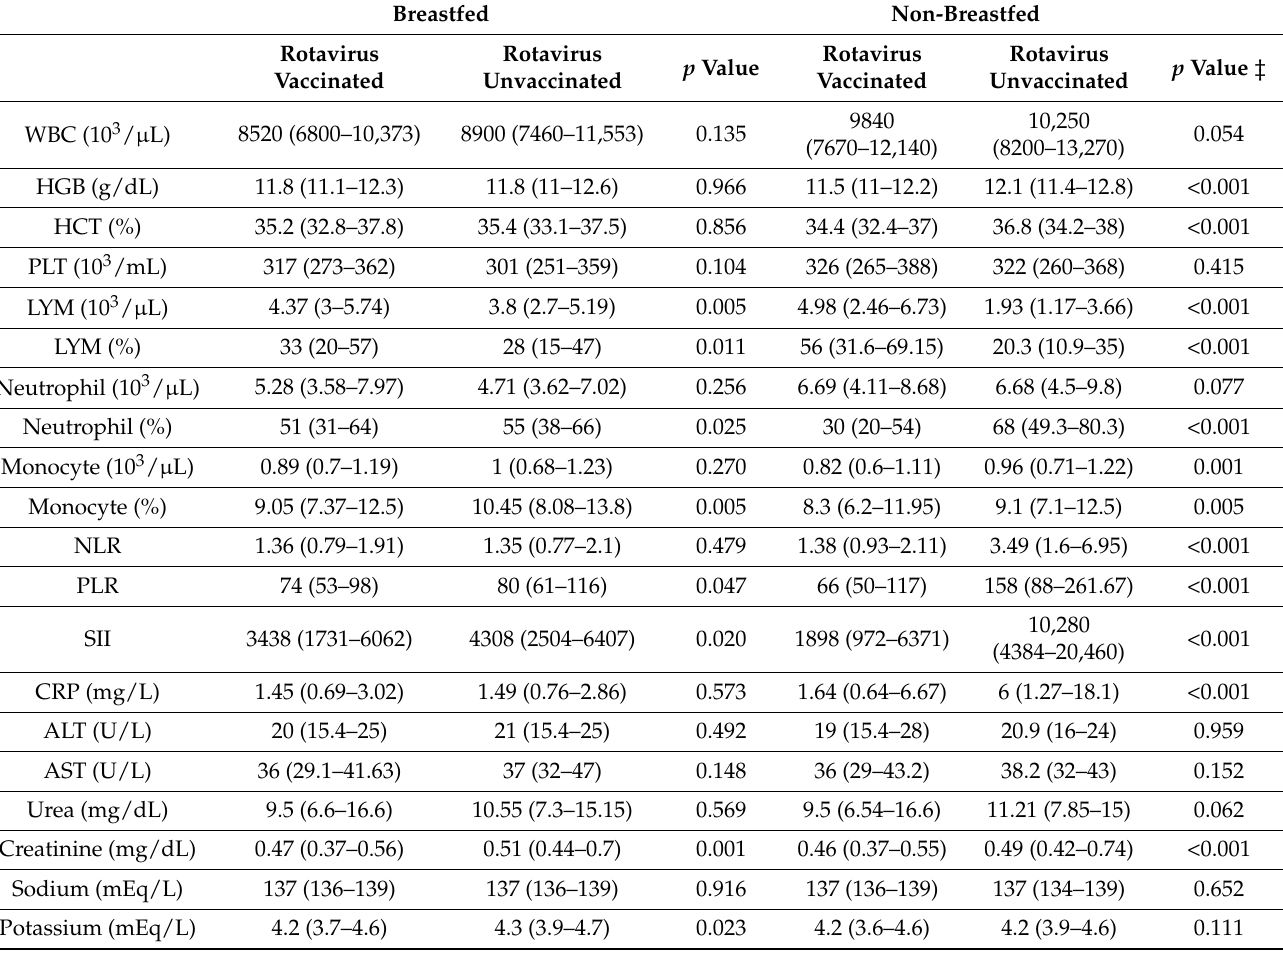
Table 4. Laboratory findings of vaccinated and unvaccinated patients with rotavirus infection in breastfed